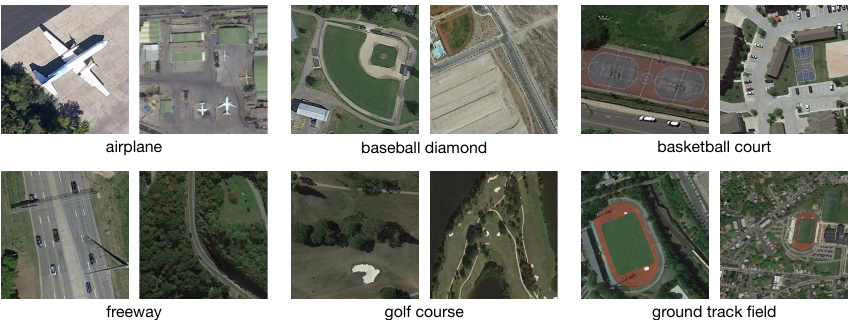
Figure 1. Examples of the inherent characteristics of remote sensing scene images, i.e., the ground objects vary in size and irrelevant objects exist.